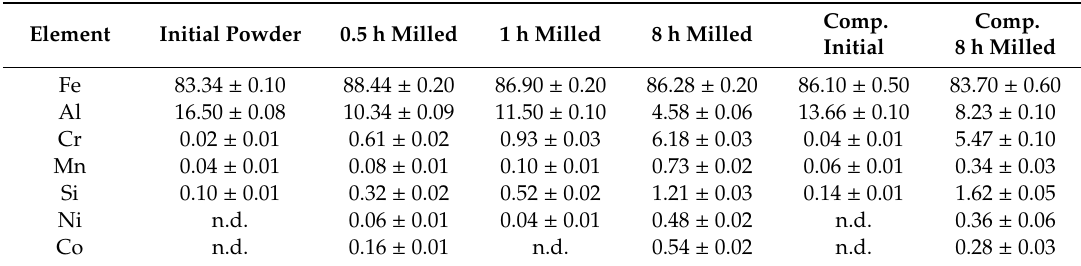
Table 1. Chemical composition of Fe28Al powder in the initial state and after milling for 0.5, 1, and 8 h measured by